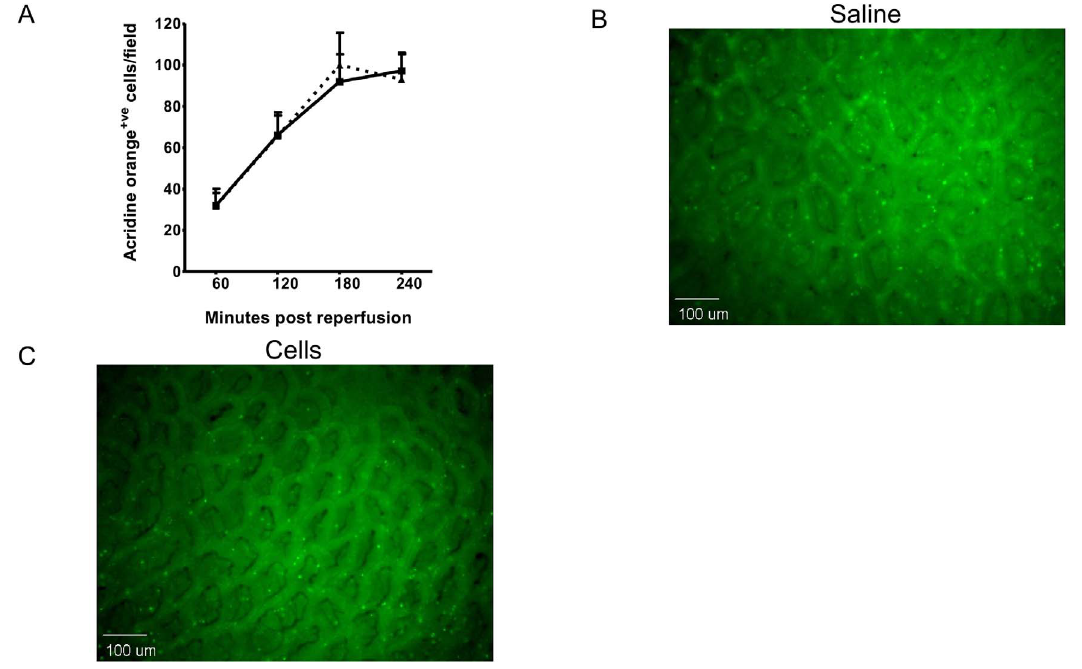
Figure 2. Recruited HPC-7 do not reduce leukocyte infiltration in IR injured intestine. (A) Leukocyte infiltration, analysed by AcrO staining, did not reduce in animals receiving 2 6 10 6 HPC-7 cells at 30 minutes post-reperfusion when compared to IR injured animals receiving a saline bolus ie. no cells. Representive images from the ileum of IR treated animals receiving (B) saline or (C) 2 6 10 6 HPC-7 are shown. Results are presented as mean cells per field 6